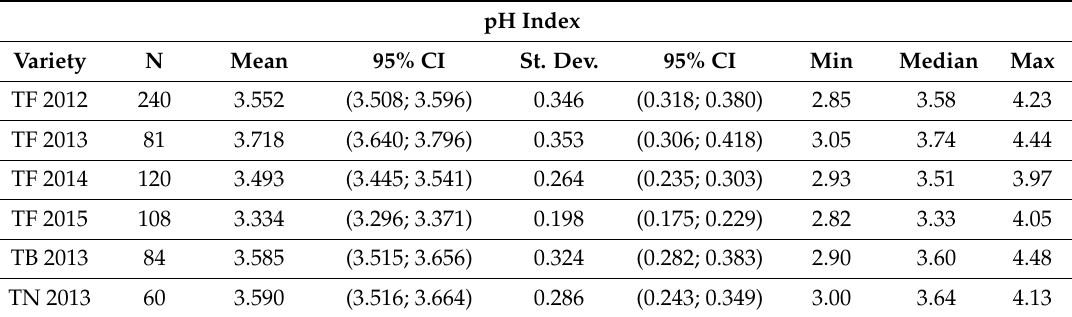
Table A2. Descriptive statistics for the pH index of the laboratory results.